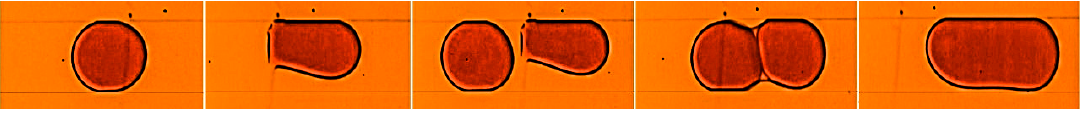
Figure 6. Sequence of trapping, fusion, and detachment of slug droplets over a narrow band of GO. The dimensions of the channel (W × H) are 200 µm × 50 µm. The width of the GO pattern is approximately 10 µm and is patterned along the width of the channel.